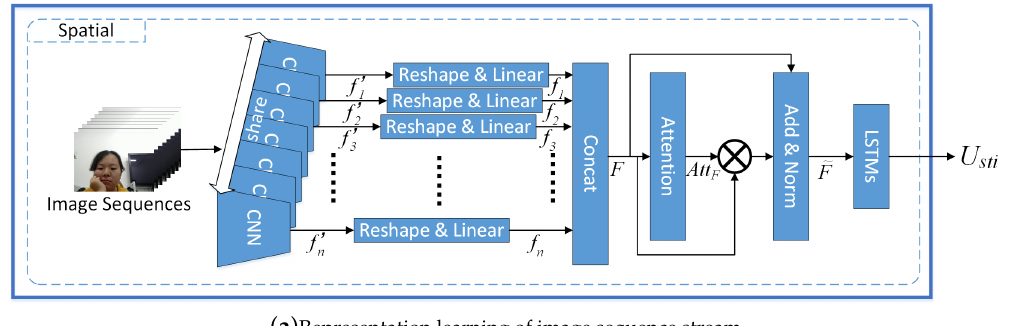
( a ) Representation learning of image sequence stream.